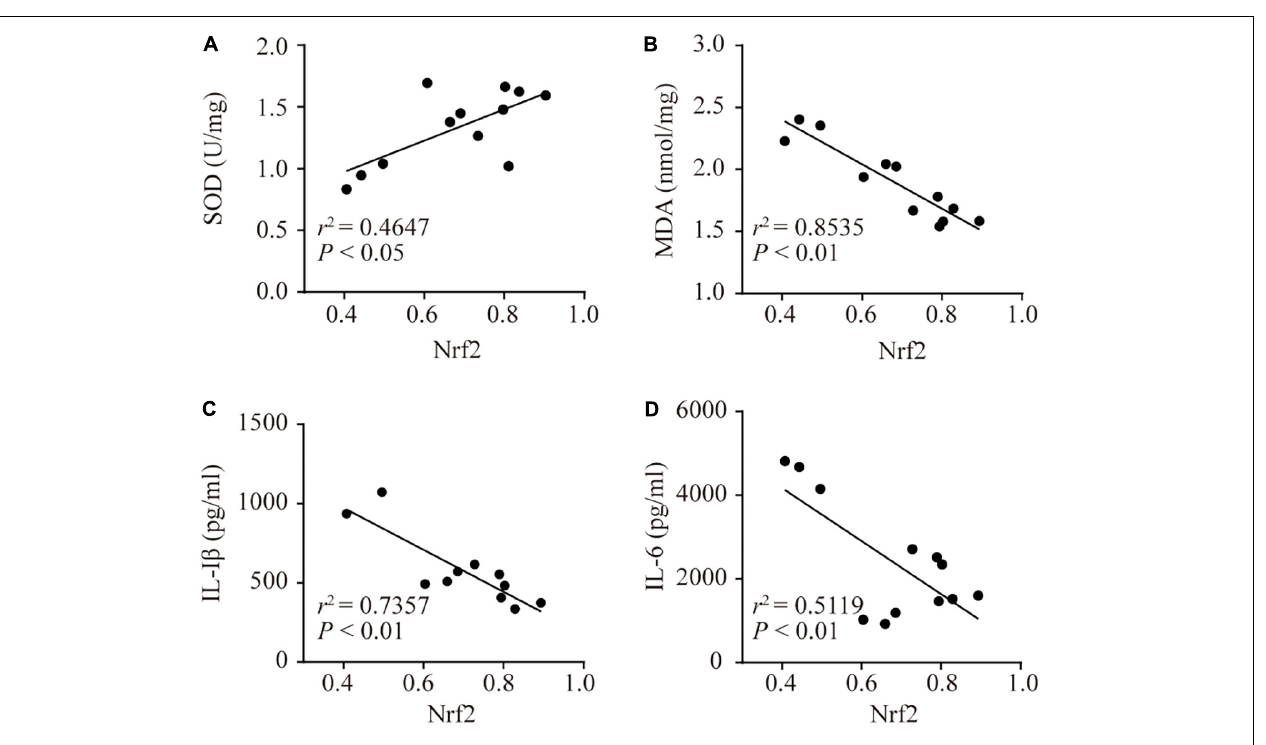
Frontiers in Pharmacology |